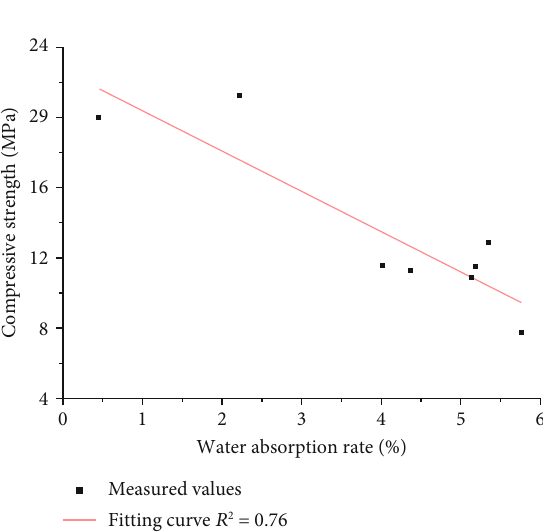
Figure 25: Relationship between the compressive strength of siltstone and water absorption of rock samples.